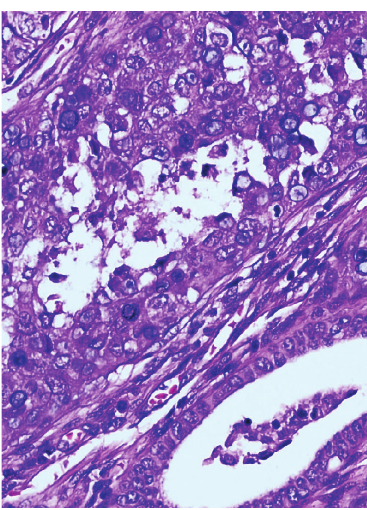
Figure 5: Cytoplasmic staining with vimentin; (H&E) × 440.